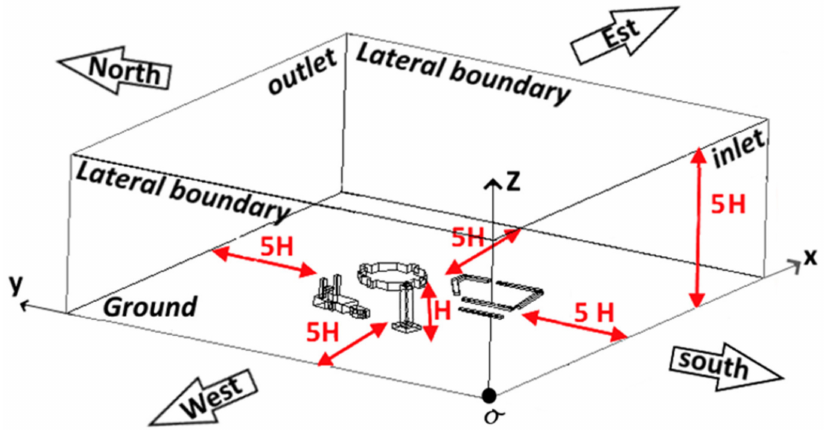
Figure 2. Geometric configuration and numerical